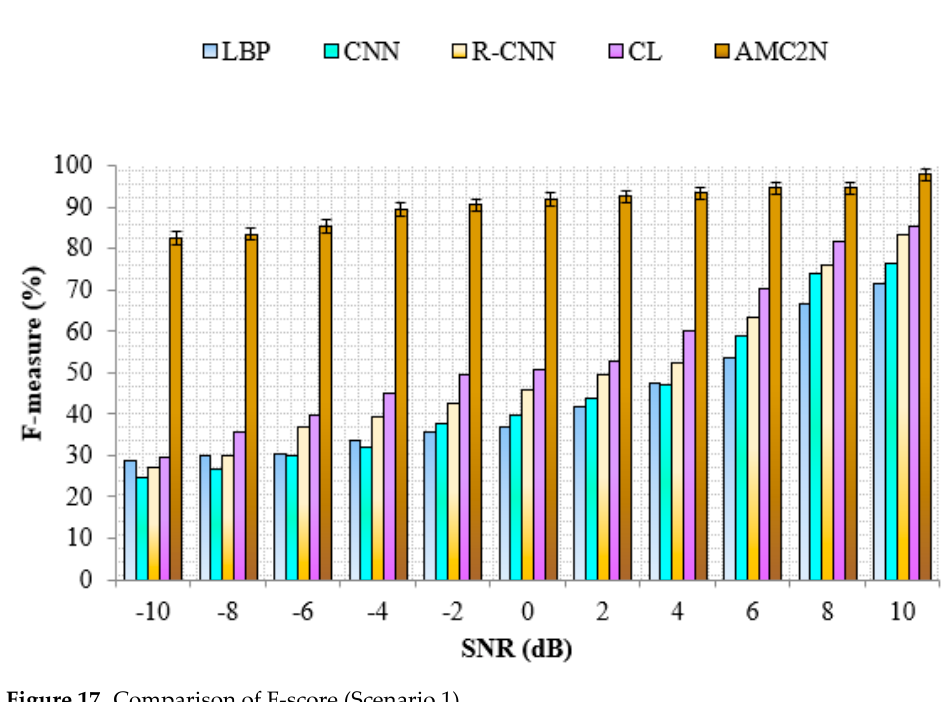
Figure 17. Comparison of F-score (Scenario 1).